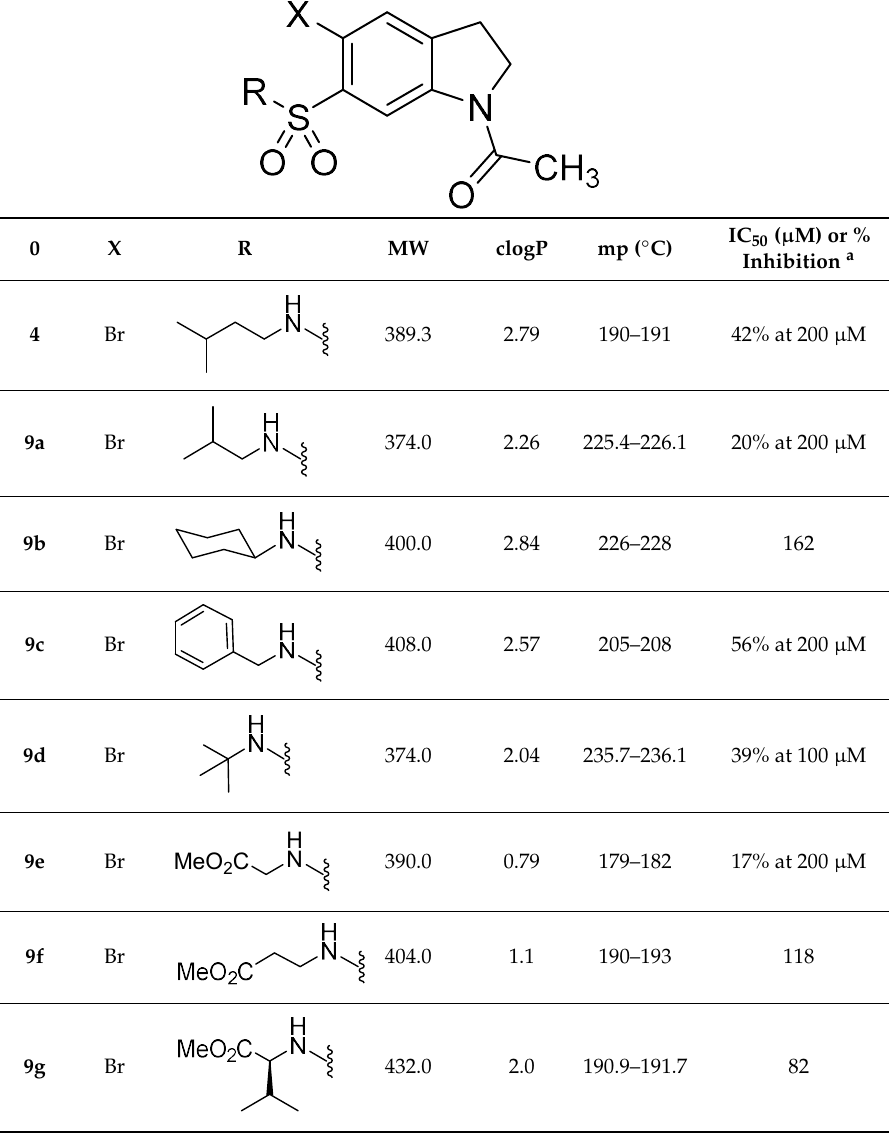
Table 1. Inhibition of DapE enzyme by synthesized compounds 4 , 9a – n , and 10a – f a